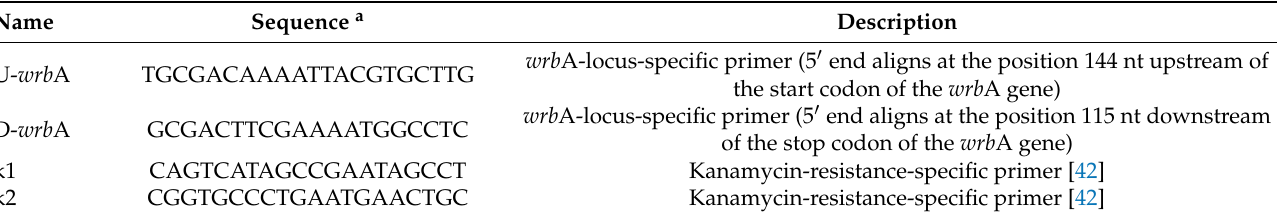
Table 1. Primers used in this